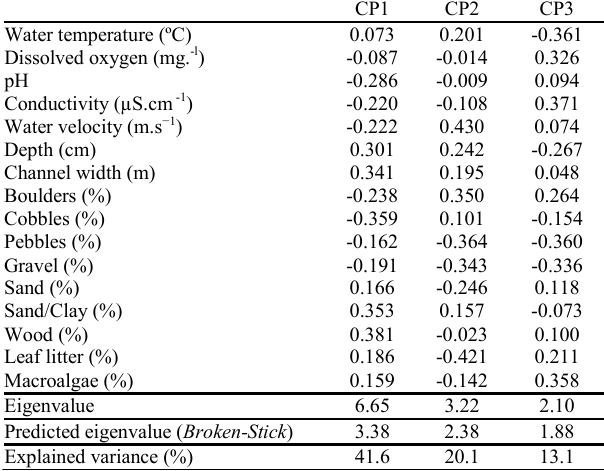
Table 2. Eigenvector, eigenvalue and variance explained by the first three axes (PCA1, PCA 2 and PCA3) with the correlation matrix of environmental variables of the Vermelho River, East Atlantic basin, Antonina, Paraná State, Brazil. Bold values indicate eigenvectors that most contributed to the axes